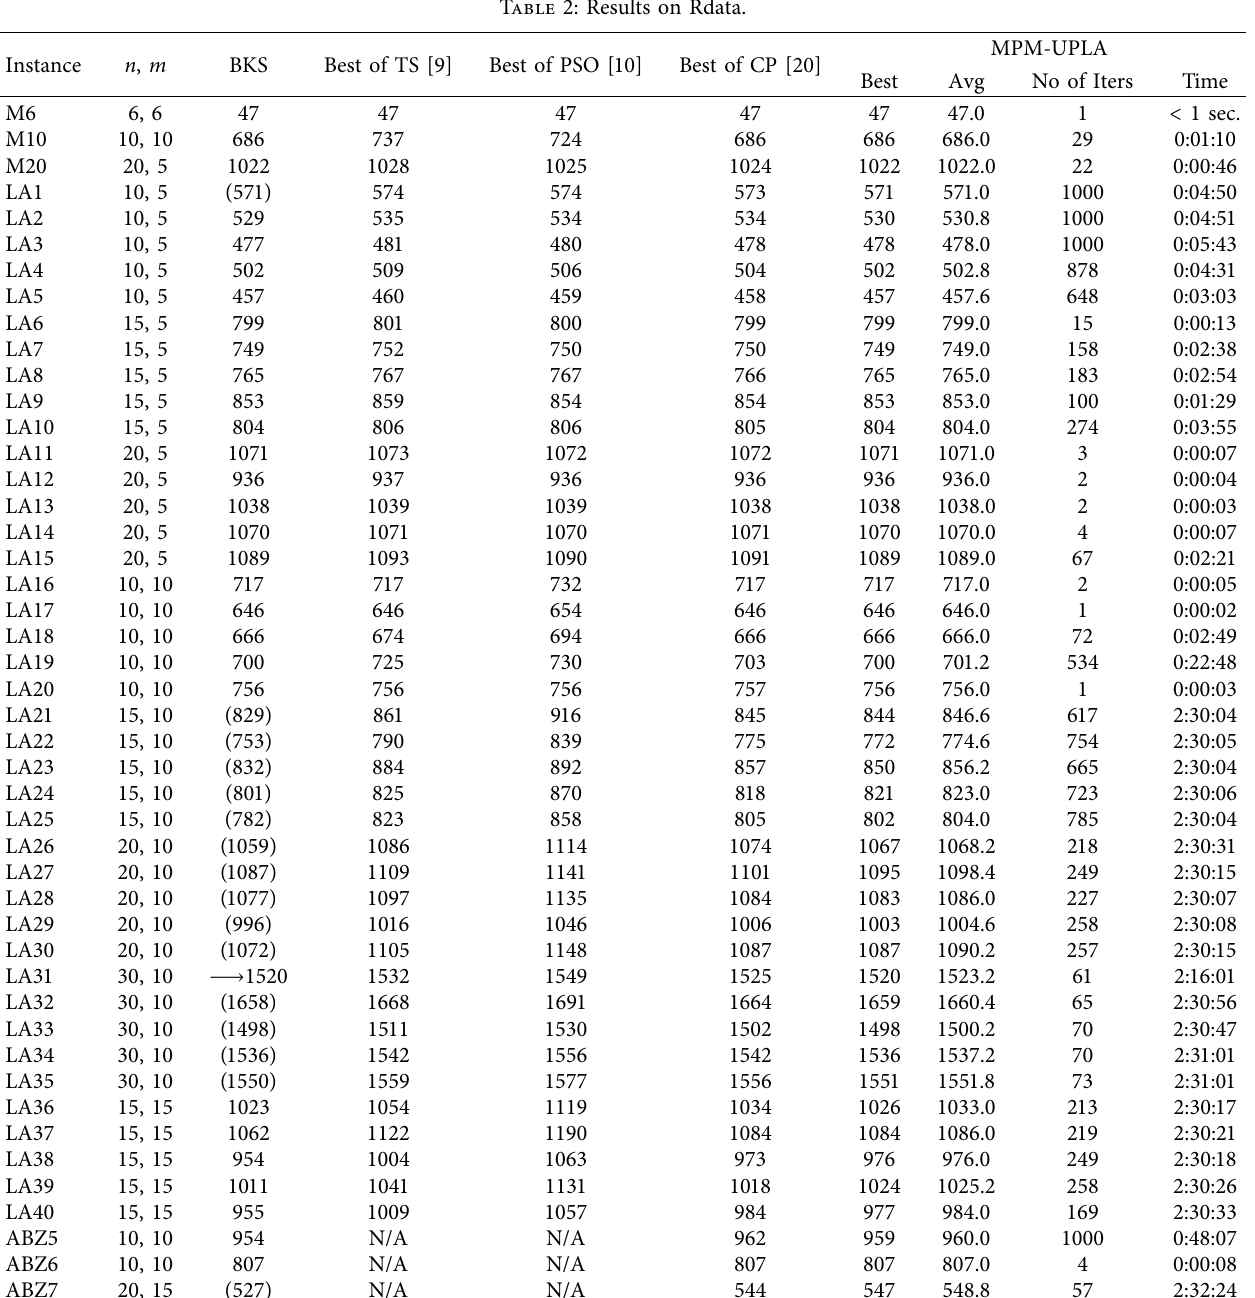
Table 2: Results on